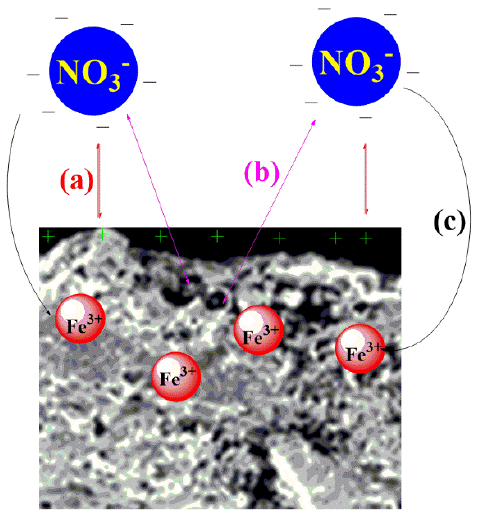
Figure 10. Adsorption mechanism proposed for nitrate ion uptake using SMCB/Fe. ( a ): positive sur- face of the adsorbent; ( b ): nitrate ions in porous biochar; ( c ): electrostatic interaction or coordination of nitrate ions and Fe 3+ cations. Table 3. Removal of nitrate contaminants from aqueous solutions by biochar-supported metal